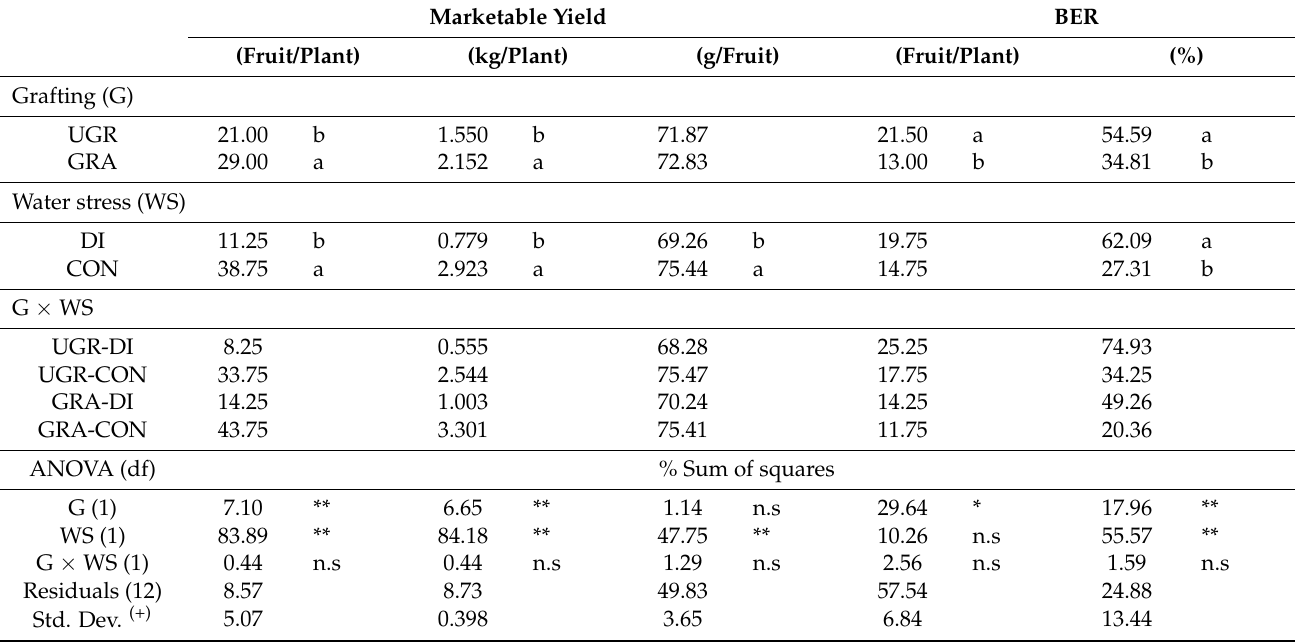
Table 2. Effect of grafting and water stress on marketable yield (fruit/plant, kg/plant, and g/fruit) and blossom end rot (BER) (fruit/plant and %). Marketable Yield BER (Fruit/Plant) (kg/Plant) (g/Fruit) (Fruit/Plant)